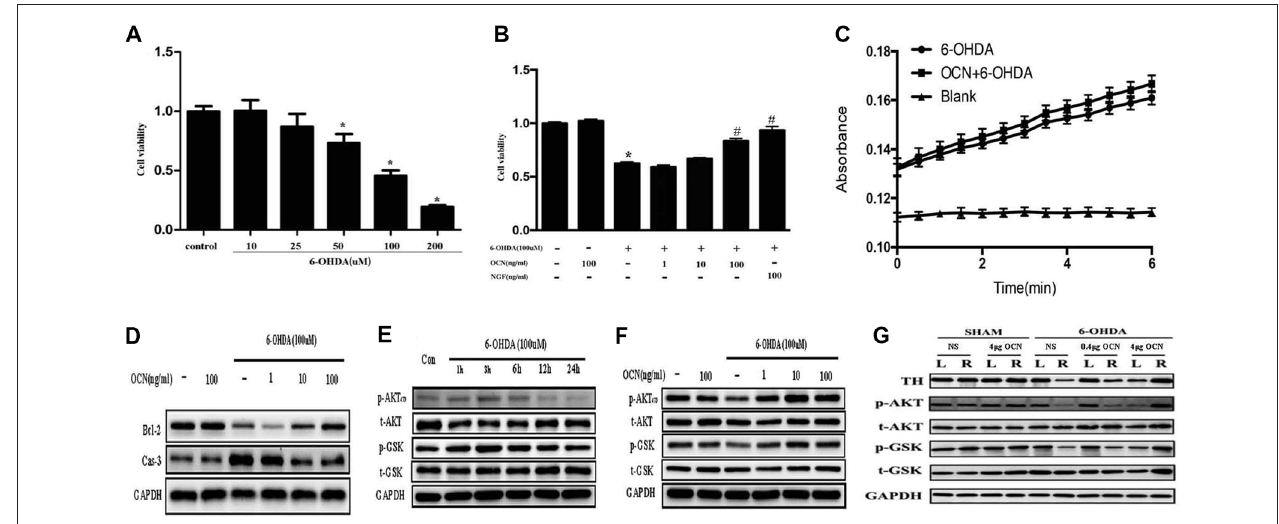
FIGURE 6 | Neuroprotective effects of OCN on 6-OHDA-induced neurotoxicity. PC12 cells were incubated with different concentrations of 6-OHDA for 24 h, and cell viability was measured by cell counting kit-8 (CCK-8; A ). Pretreatment of PC12 cells with various concentrations of OCN (1–100 ng/ml) was performed 2 h before exposure to 100 µ M 6-OHDA, and the cell viability was measured at 24 h (B) . The effects of OCN on the auto-oxidation of 6-OHDA were measured spectrophotometrically at 490 nm using a microplate reader (C) . The results from western blots showed that treatment with 100 µ M 6-OHDA increased the expression of caspase-3 and decreased the expression of bcl-2, and both changes were reversed by pre-incubation with OCN (D) . 6-OHDA decreased the expression of phosphorylated AKT (Ser473) and phosphorylated GSK3 β (Ser9) at 24 h (E) , and both reductions were reversed by pretreatment with OCN (F) . Similarly, 6-OHDA injection into the right striatum also resulted in decreased expression of p-AKT and p-GSK3 β , and both reductions were inhibited by direct injection of OCN into the striatum (G) . Values were obtained from three independent experiments. ∗ P < 0.05 (compared with the control group), # P < 0.05 (compared with the 6-OHDA